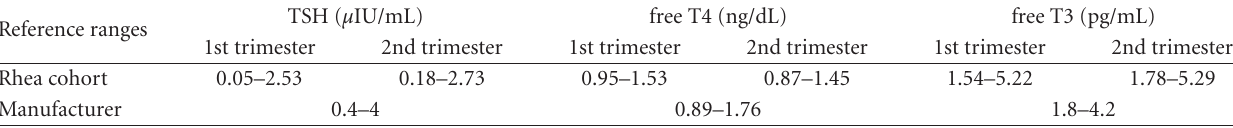
Table 3: Comparison between reference ranges for thyroid hormones as calculated by our analysis and those proposed by the manufacturer. Reference ranges